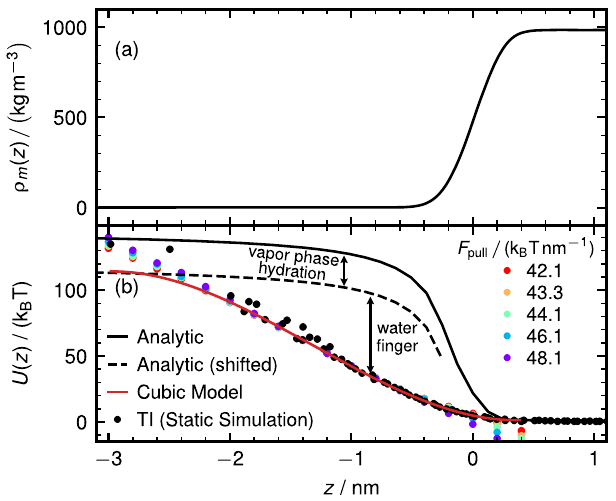
Fig. 3 Ion free energy from thermodynamic integration (TI). a Water mass density pro fi le ρ m ( z ) of the water – vapor interface. b Chloride free energy pro fi le U ( z ) obtained by TI (protocol (III), black spheres) where the ion is held at different fi xed positions. The error bars are of the same size as the data points. The black solid line shows the analytic image – charge potential for a charged sphere at a sharp fl at dielectric interface 29 , the black dashed line is shifted by the vapor hydration free energy U hyd = − 26 k B T. The red solid line is a cubic polynomial fi t to the TI data in the range − 2.0nm < z < 0.4 nm. Colored dots show the free energy obtained from the logarithm of the ion distribution of protocol (IV) simulations at constant force F pull .